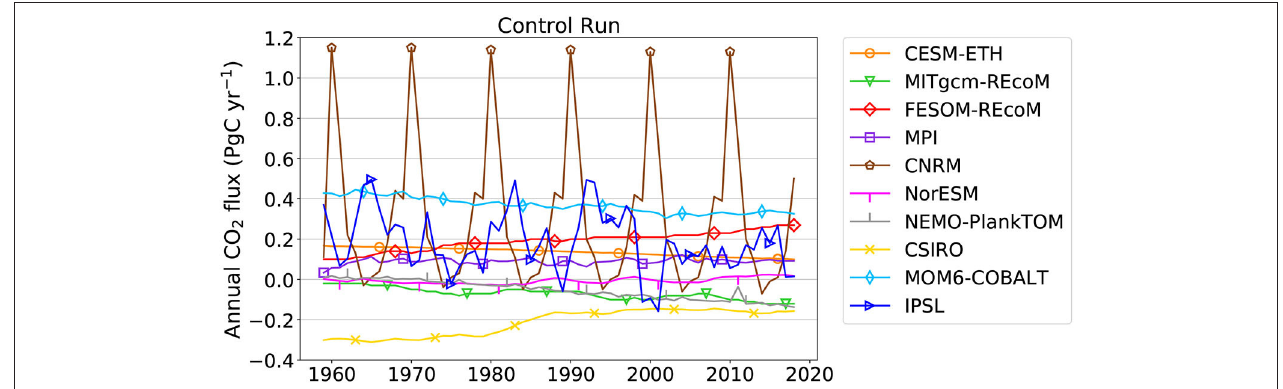
FIGURE 1 | Annual air-sea CO 2 flux in control simulation (simulation B) of individual Global Ocean Biogeochemical Models. This is equivalent to F simB = F nat,ss + F drift + bias (Equation 5), where any flux different from zero is considered a bias and any temporal change in the control simulation is considered a drift. Positive: CO 2 flux into the